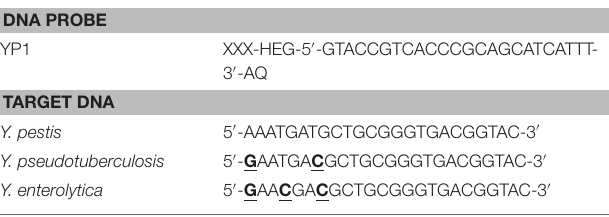
TABLE 2 | Sequences of anthraquinone modified DNA probe and target DNA for the gro EL gene target of Y. pestis . DNA